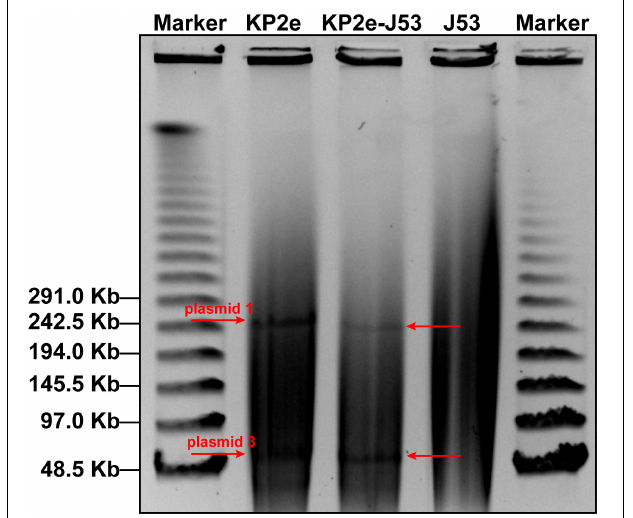
FIGURE 1 | Determination of bla NDM − 6 -carrying plasmids by S1-PFGE/southern blot. The S1-digested genomic DNA samples were analysed on the PFGE gel, then subjected to southern blot hybridisation with a DIG-labelled probe specific to bla NDM .